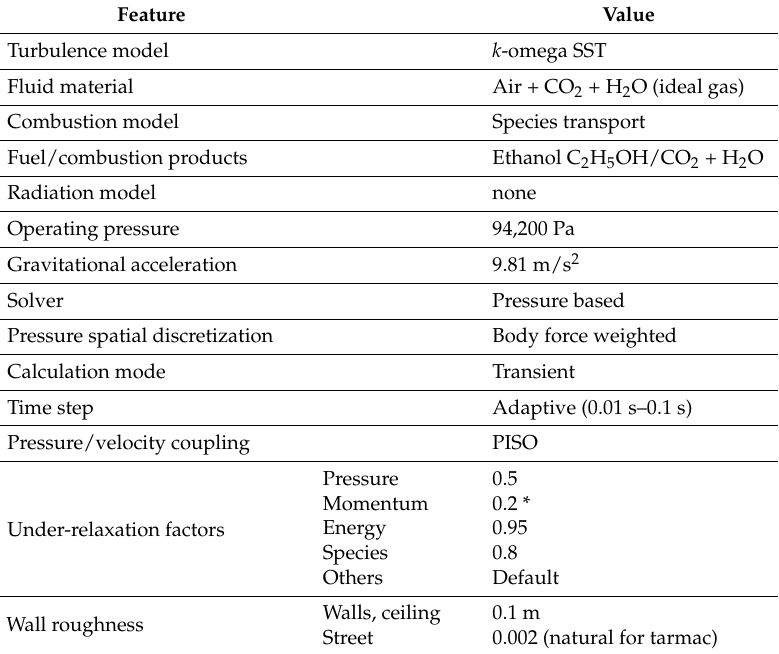
Table 4. Numerical model summary.